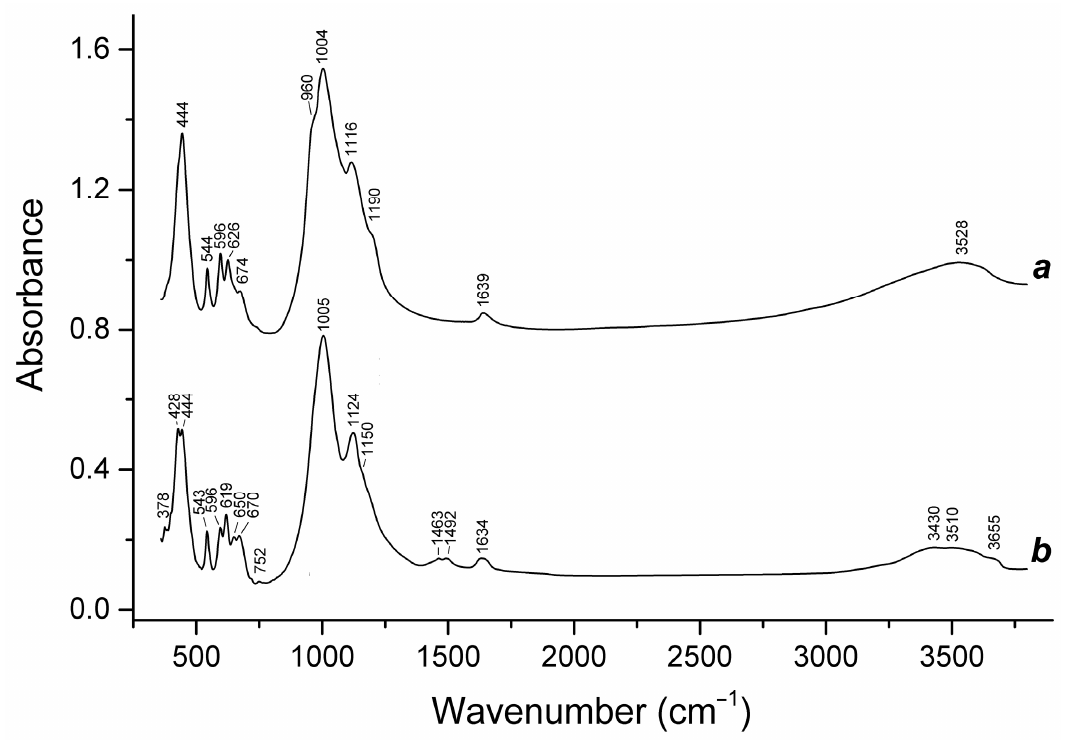
Figure 17. Infrared spectra of ( a ) steudelite, Sample 12, and ( b ) alloriite, Sample